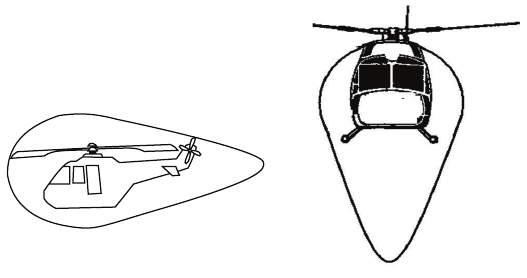
Figure 15: Double drop section: lateral view (left) and vertical section (right).